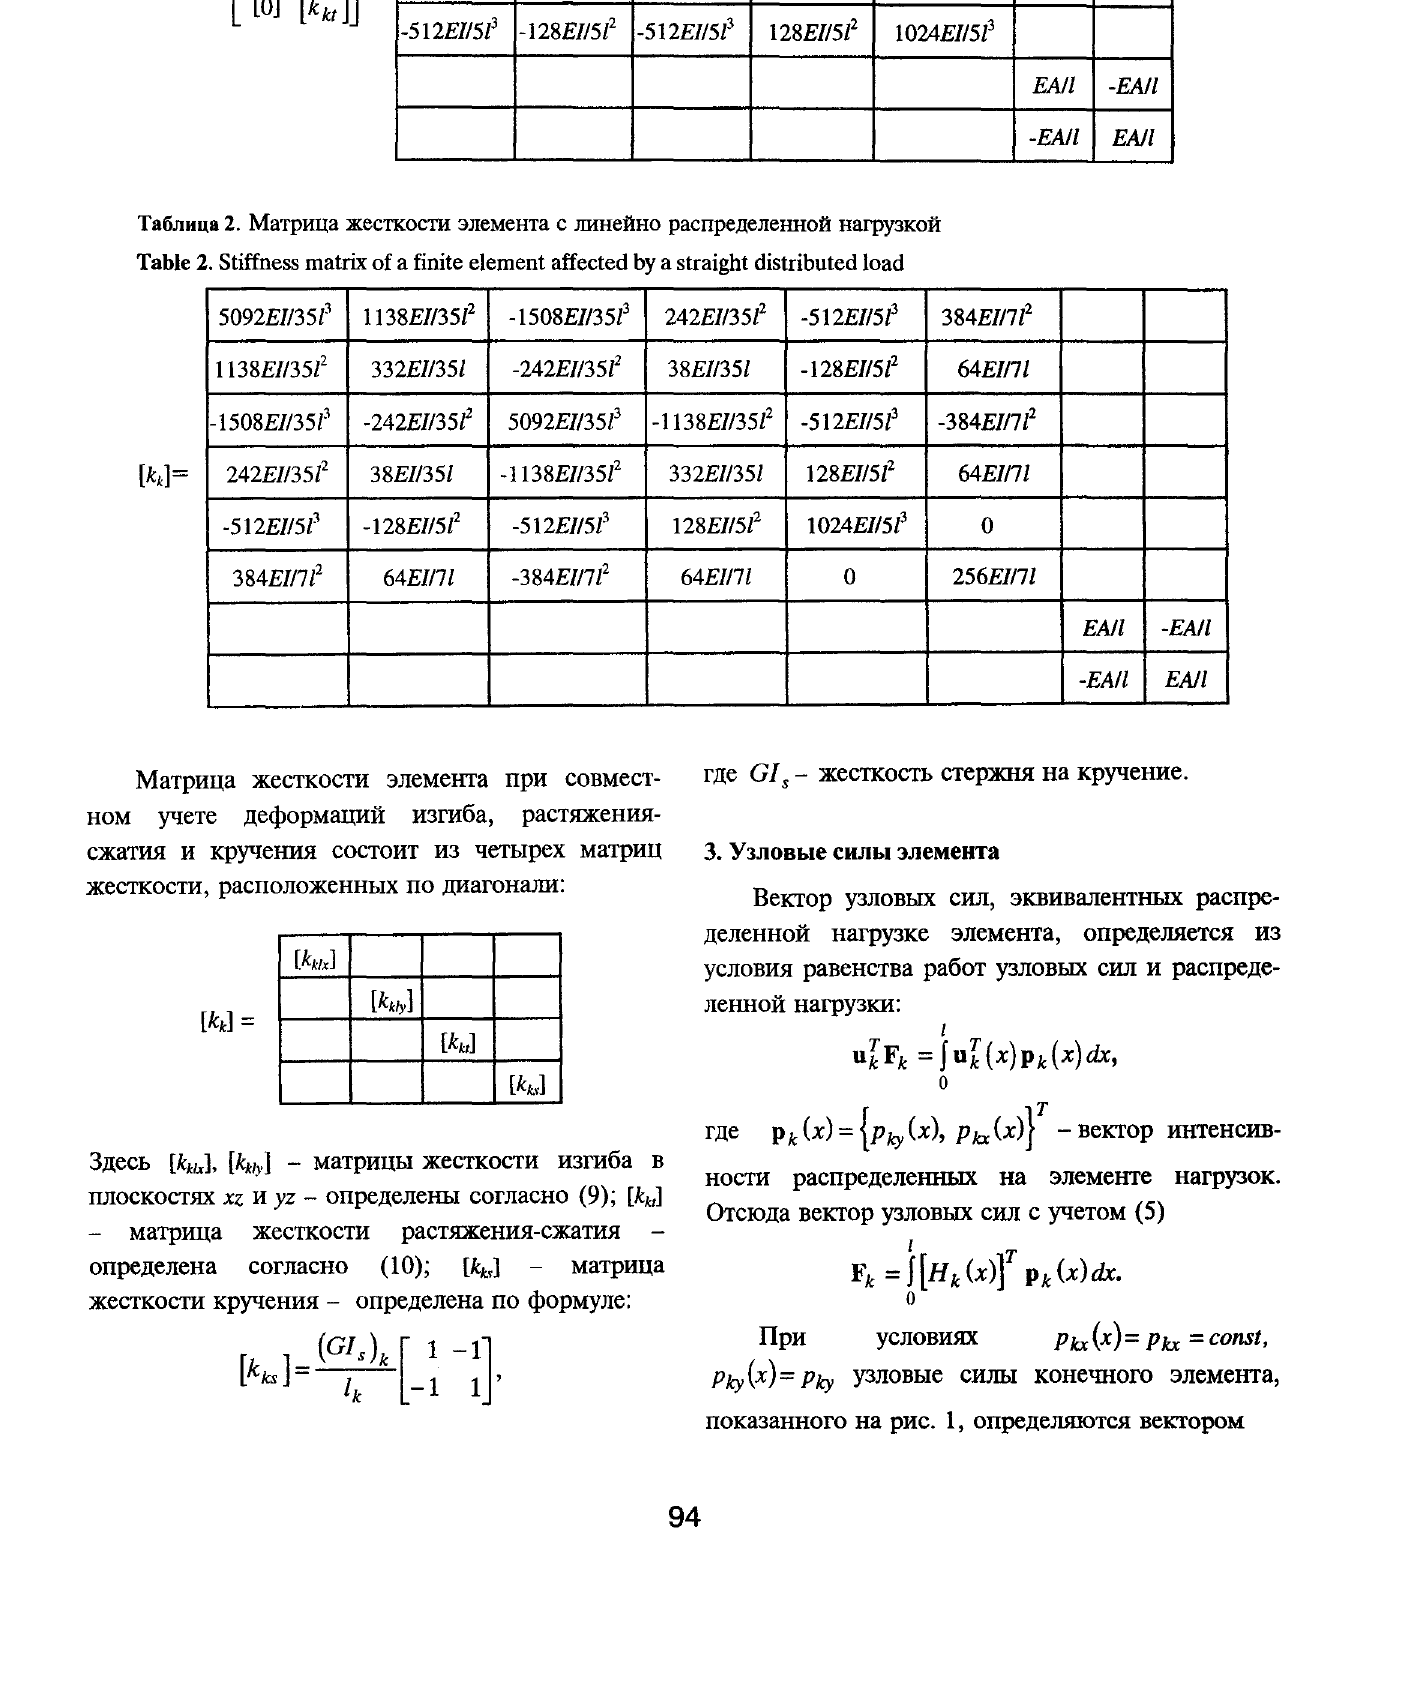
Table 2. Stiffness matrix of a finite element affected by a straight distributed